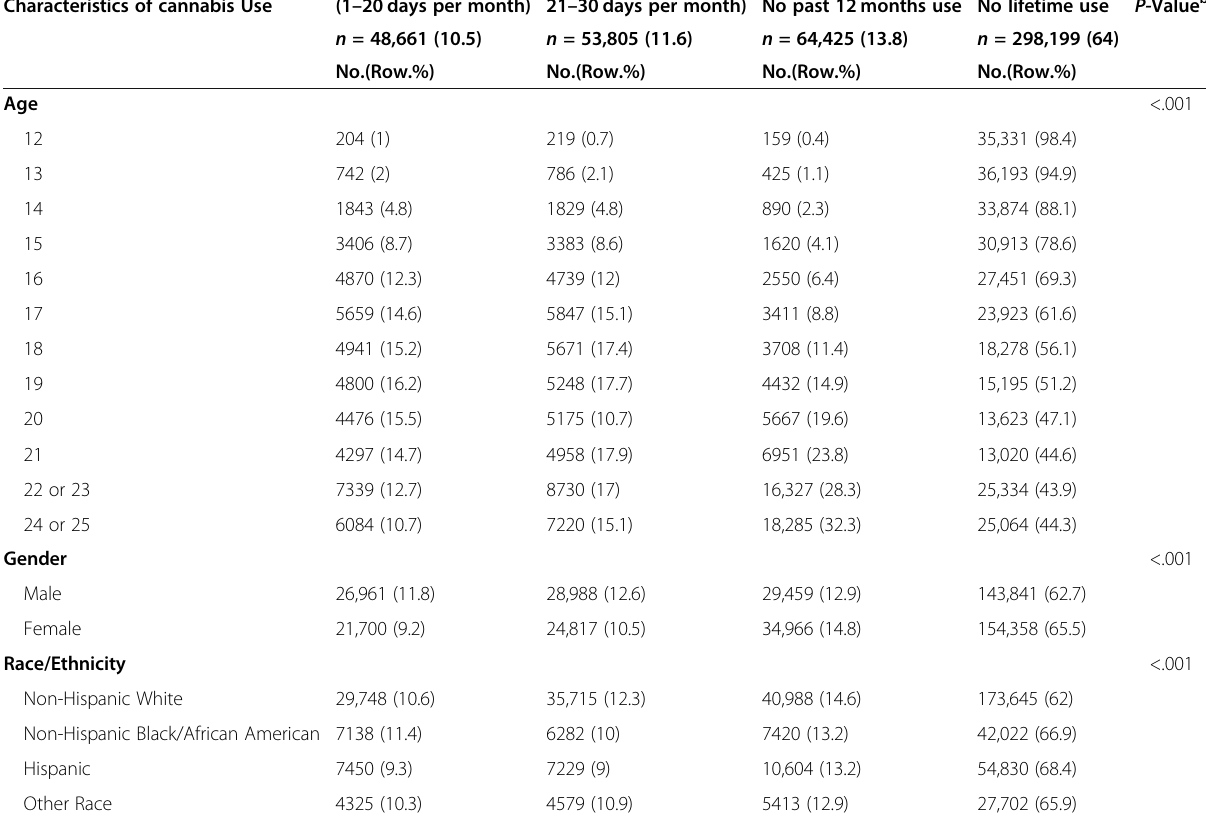
Table 1 Past-year cannabis use by demographic characteristics of respondents a Characteristics of cannabis